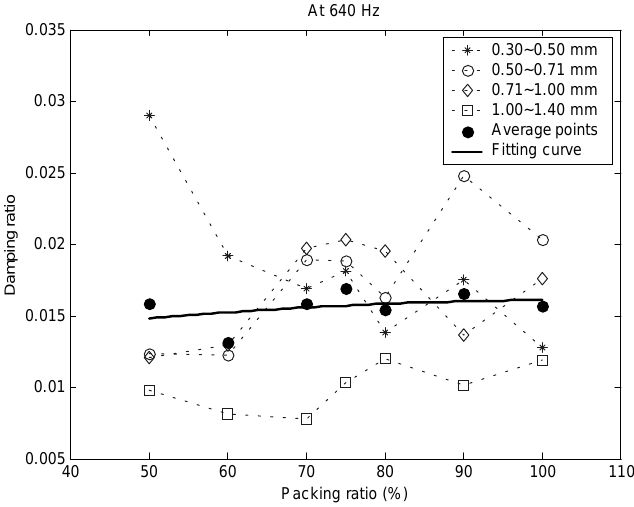
Fig. 5. Damping ratio vs. packing ratio for different particle diameters at 640 Hz.